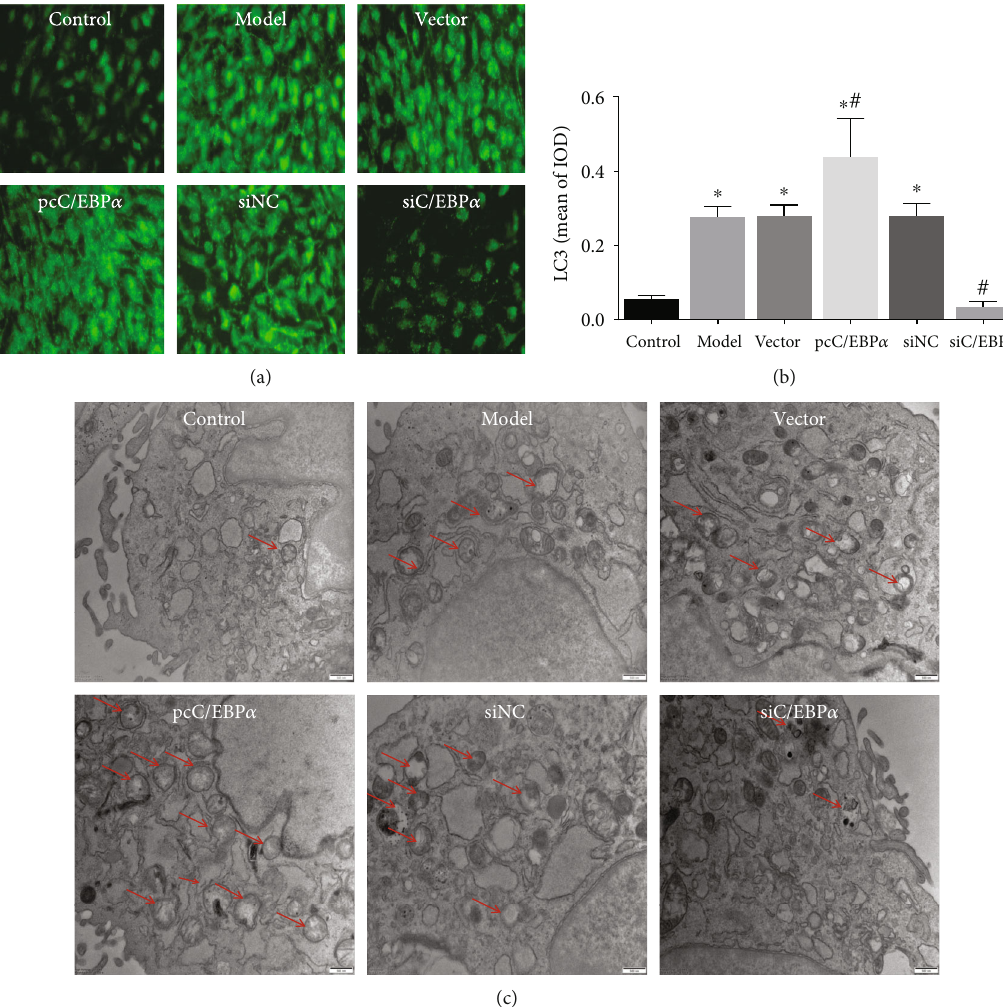
Figure 5: The formation of LC3 puncta and autophagosome varied with C/EBP α gene expression in angiotensin II-treated VSMCs. Representative LC3 puncta images (a) of Ang II-treated VSMCs and the quantitation of LC3 IOD (b) of positive cells ( ∗ P < 0 : 05 vs. control, # P < 0 : 05 vs. model). (c) The autophagosome in each group observed using TEM.